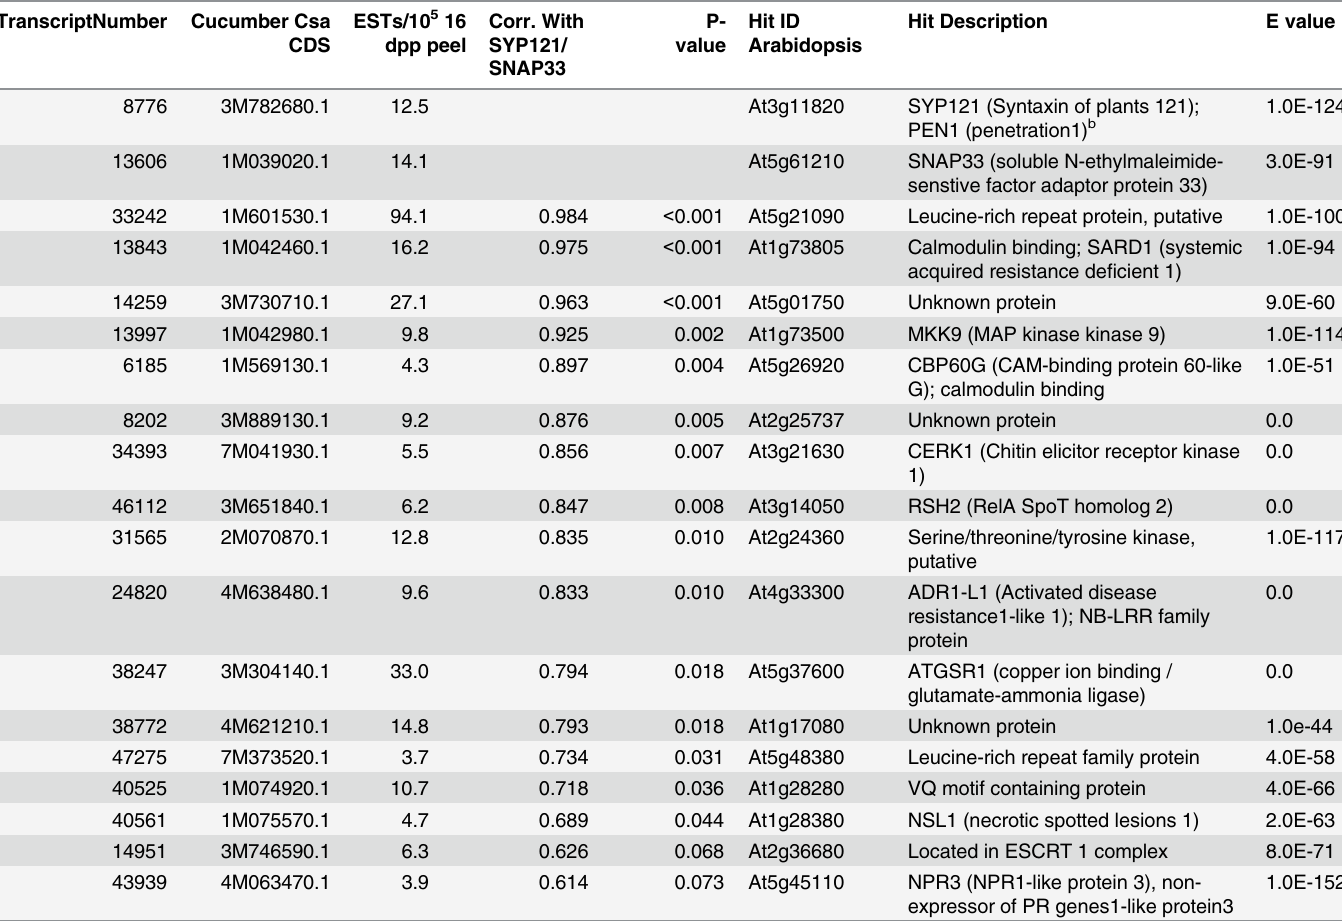
Table 4. Co-expression analysis of putative cucumber homologs of MLO2/SYP121/SNAP33- co-expressed genes from Arabidopsis. Putative homologs of MLO2/SYP121/SNAP33- co-expressed genes from Arabidopsis (as identified by Humphrey et al.[31] were tested for co-expression with cucum- ber SYP121 and SNAP33 genes in cucumber pericarp (0, 4, 8, 12, and 16 dpp) and peel (8 and 16 dpp) samples. Corr. With TranscriptNumber Cucumber Csa ESTs/10 5 16 dpp peel CDS